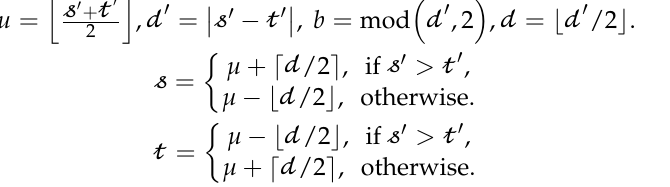
Algorithm 2 Data Embedding for Complex Blocks